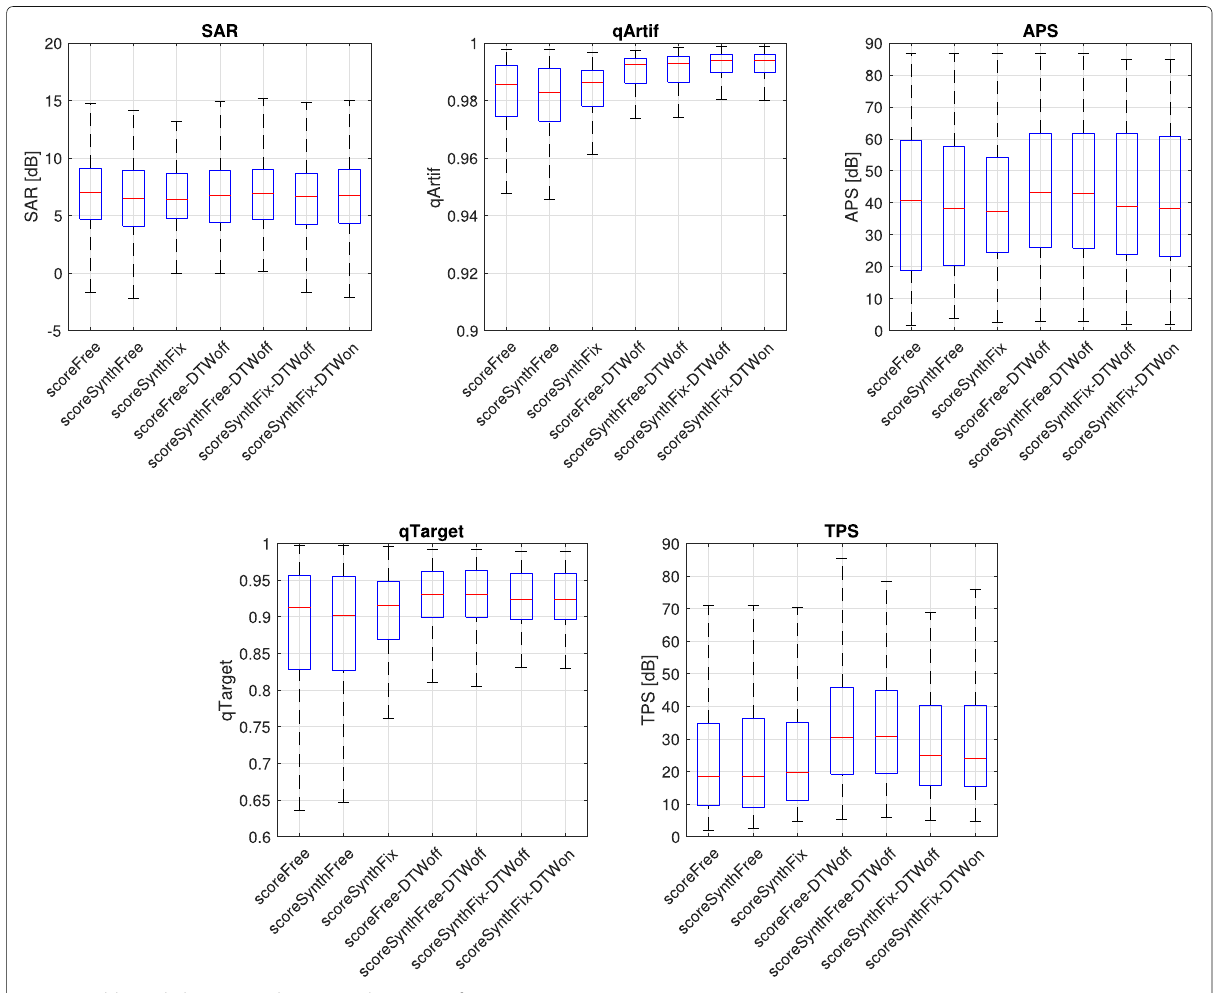
Fig. 12 Additional objective and perceptual measures for Fig. 6